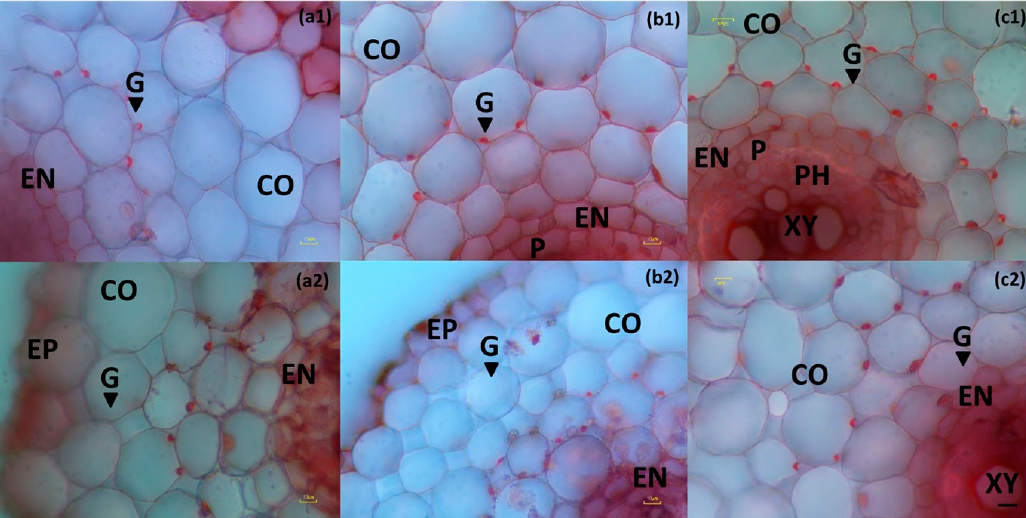
Figure 8. Freehand cross sections of second-order lateral roots under well-irrigated conditions ( a1 , b1 and c1 ) and drought stress conditions ( a2 , b2 and c2 ) at 21, 28 and 35 DAE. CO, cortex; EN, endodermis; G, phi-thickening or cell wall ingrowth; P, pericycle; PH, phloem; XY, xylem; Scale bar = 10 µm; 40×.